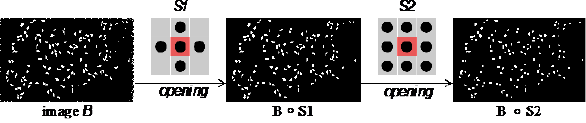
Algorithm 1 . Morphological-Based BPH Detection